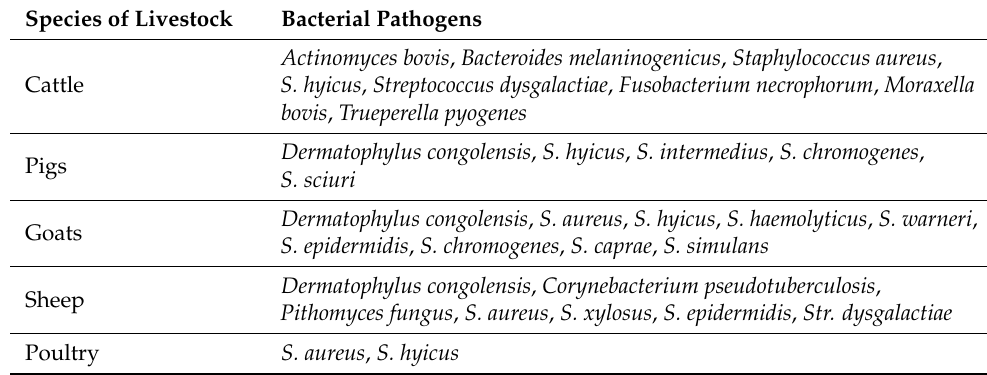
Table 1. The most common bacterial pathogens in the diseased skin of livestock [14]. Species of